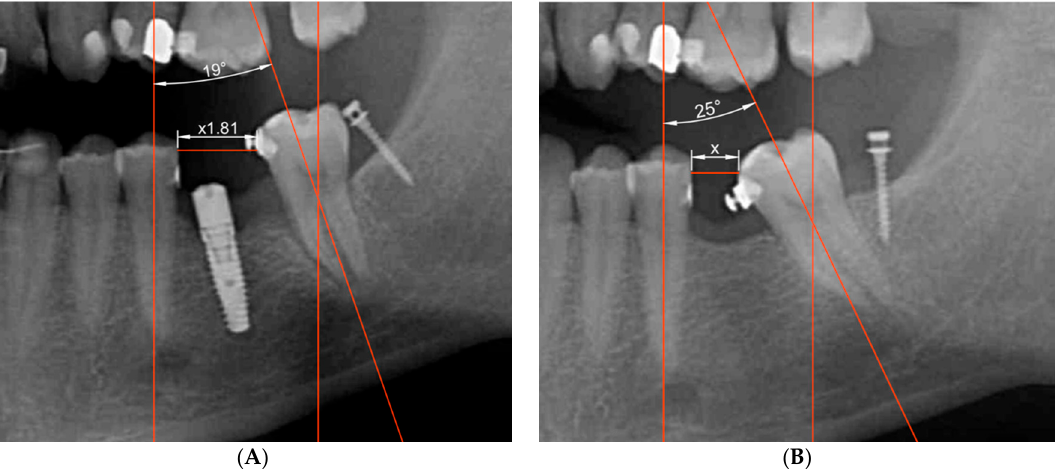
Figure 3. ( A ) Illustration of pre-treatment angulation and distance measurements taken from radiographs. ( B ) Illustration of post-treatment angulation and distance measurements taken from radiographs.